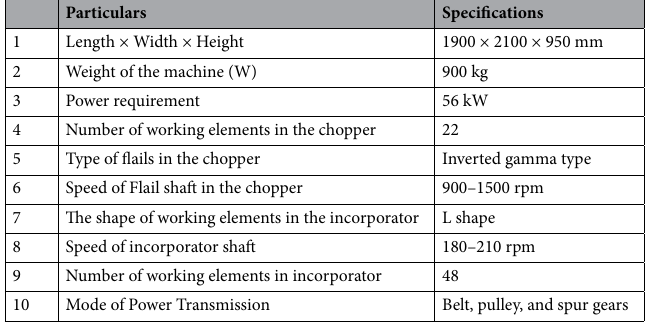
Table 4. Specification of the developed residue management machine.